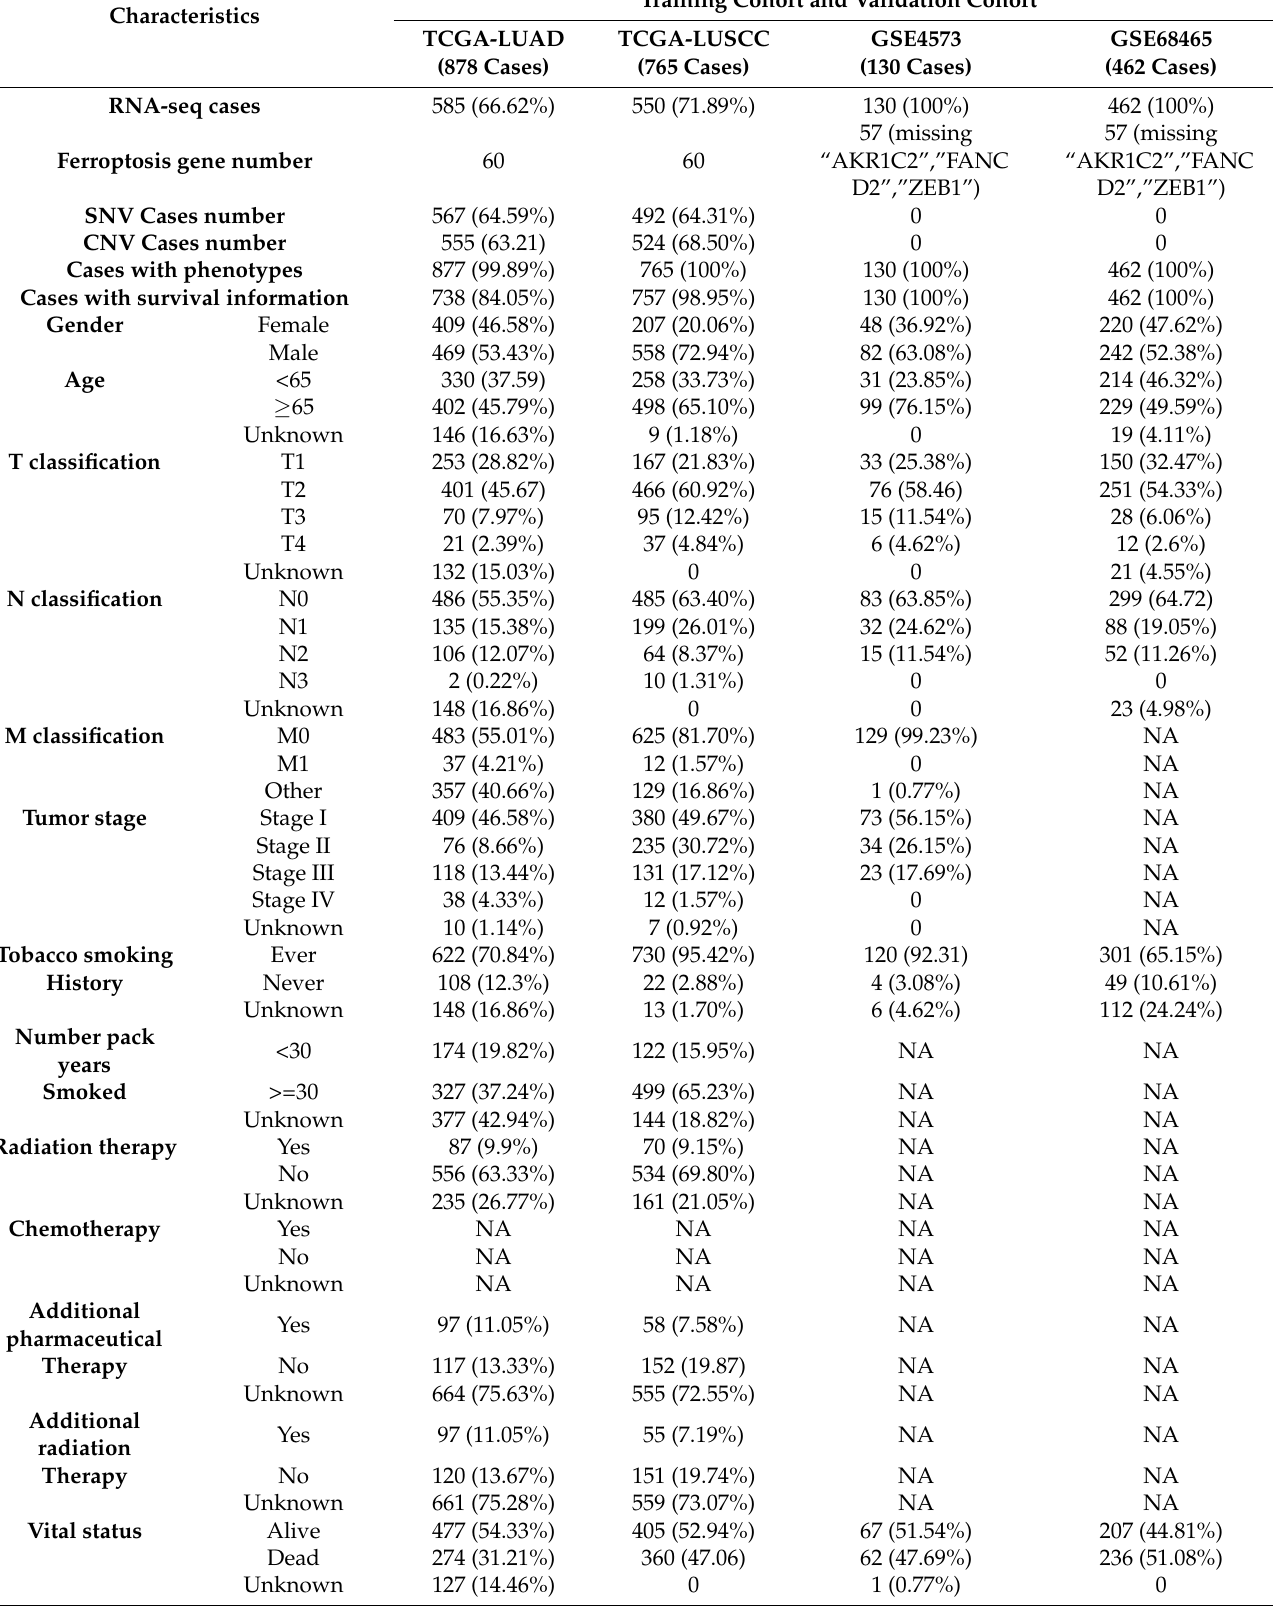
Table 1. Clinical characteristics of the patients involved in the